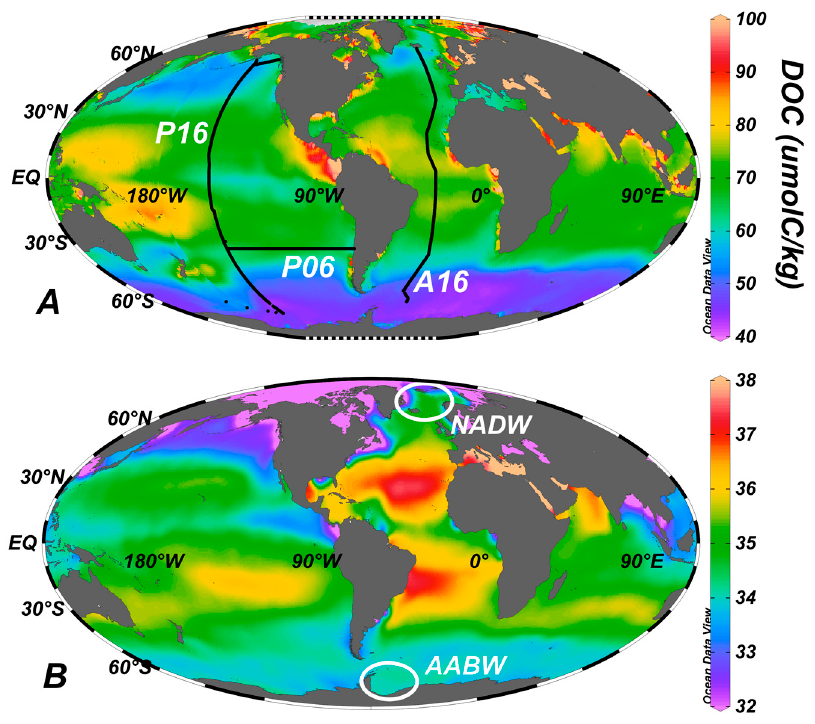
Figure 2. Modeled surface ocean distribution of ( A ) DOC ( μ molC/kg) [15] and ( B ) gridded salinity (unitless) in August [16]. Ocean sections A16, P16, and P06 are also shown, the data for which are shown in Figures 1 and 3. Figures were created using Ocean Data View [17]. White ellipses indicate formation locations of North Atlantic Deep Water (NADW) and Antarctic Bottom Water (AABW).